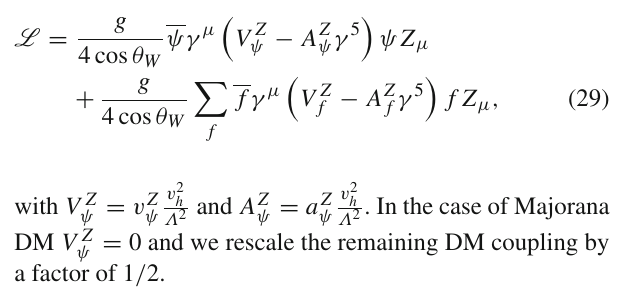
Fig. 5 Illustration of the SM-Higgs portal in the relevant bi- dimensional planes for a scalar (left panel), fermionic (middle panel) and vectorial (right panel) DM. In each plot, the red line represents the model points featuring the correct DM relic density. The blue region is excluded by the current SI DD limits. The magenta region would be